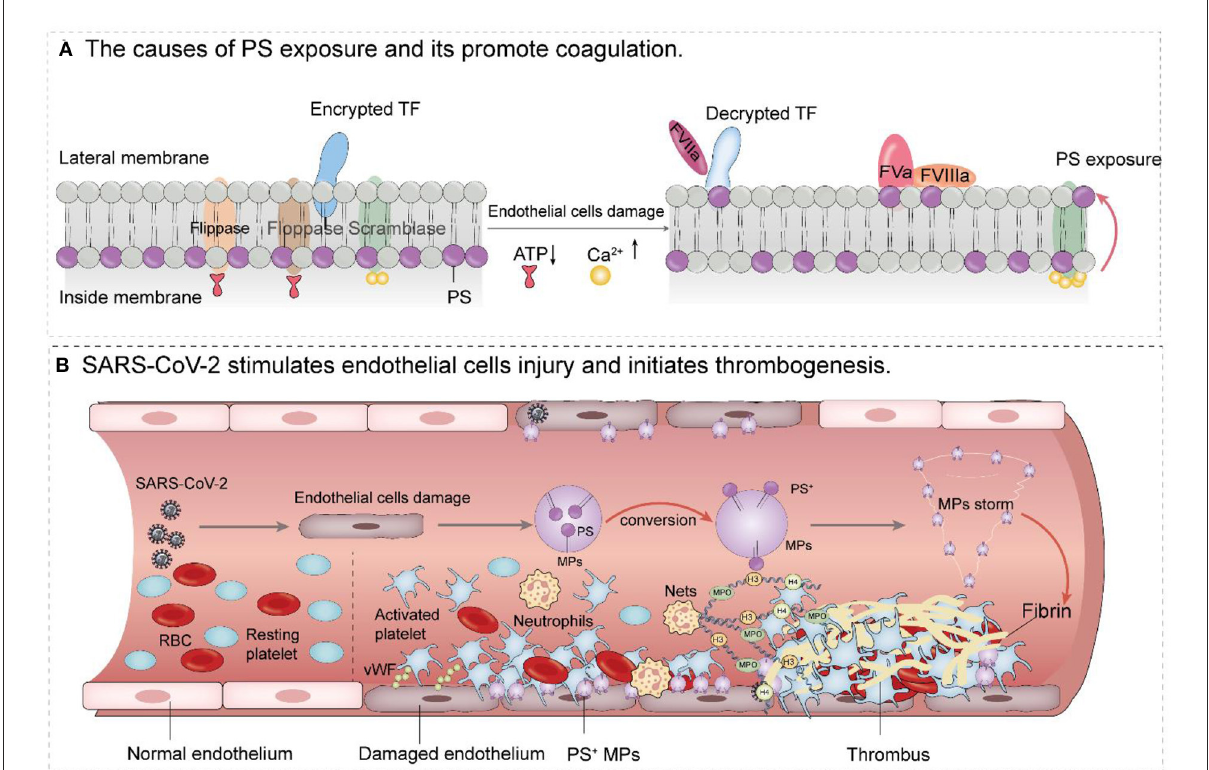
FIGURE2 Mechanism of PS + MPs promoting thrombosis after endothelial cells injury. (A) When endothelial cells are damaged, the two ATP-dependent enzymes are unable to function due to energy depletion. However, as intracellular Ca 2 + concentration, the activated scramblase flips PS to the outer membrane where it initiates coagulation PS provides a scaffold for the activity of factors VIII and V, which binding membranes through their C2 domains, and factors II, VII, IX, and X, which bind using their Gla domains. These factors combine to form the intrinsic (FXIa-FVIIIa-Ca 2 + -PL) factor X enzyme complex and the prothrombin complex (FXa-FVa-Ca 2 + -PL) Damaged endothelial cells can also upregulate the expression of tissue factor, which is activated in the presence of membrane PS and then forms the TF-VIIa complex that participates in exogenous coagulation. (B) SARS-CoV-2 causes endothelial dysfunction and thrombosis. After endothelial cell injury, stimulated platelets were transformed from the resting state to the activated state, and PS + microparticles were released from the surface of endothelial cells to form a particle storm. Platelet adhesion, coupled with PS exposure, stimulates the activation of the clotting cascade, which ultimately leads to thrombosis (The involvement of neutrophils and Nets in endothelial cell injury and thrombosis is also shown in B